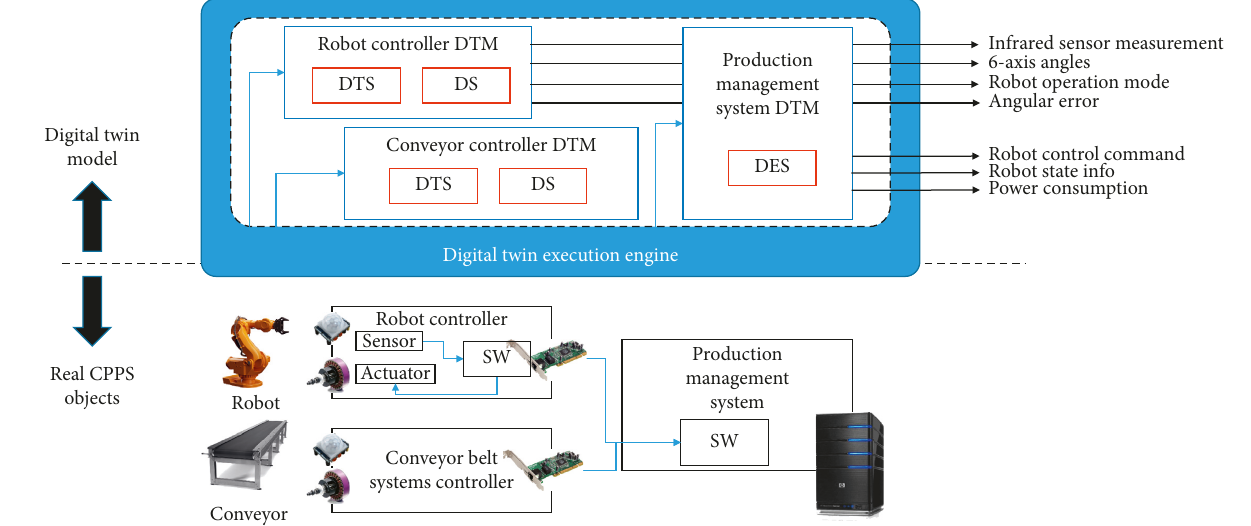
Figure 5: Monitoring scenario of DigTwinOps